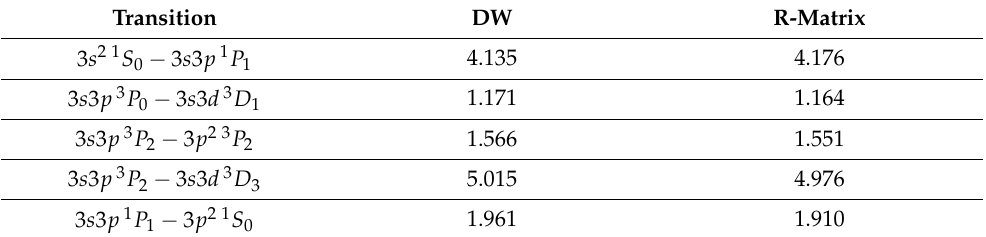
Table 11. Comparison of collision strengths in Fe XV obtained from DW and R-matrix